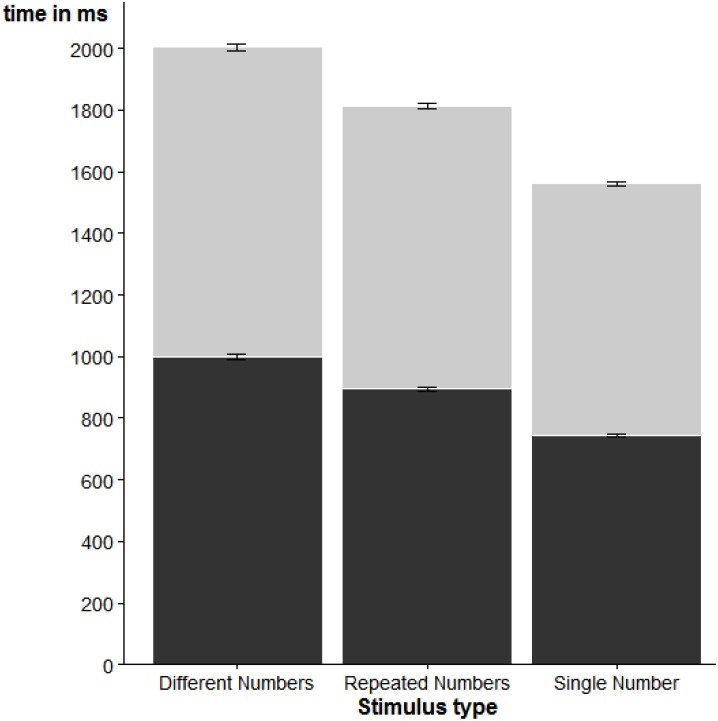
Average RT (dark portion) and MT (light portion) for the different stimulus categories. Error bars represent one standard error of the mean.